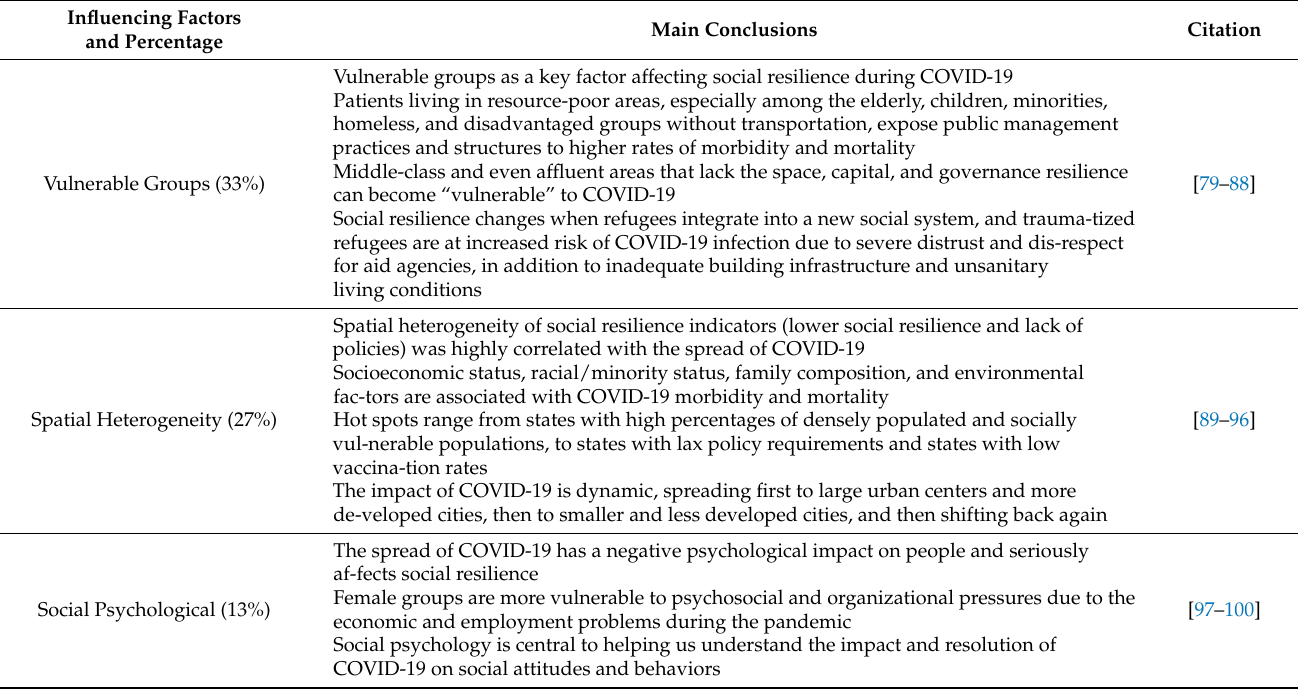
Table 3. The factors influencing social resilience to